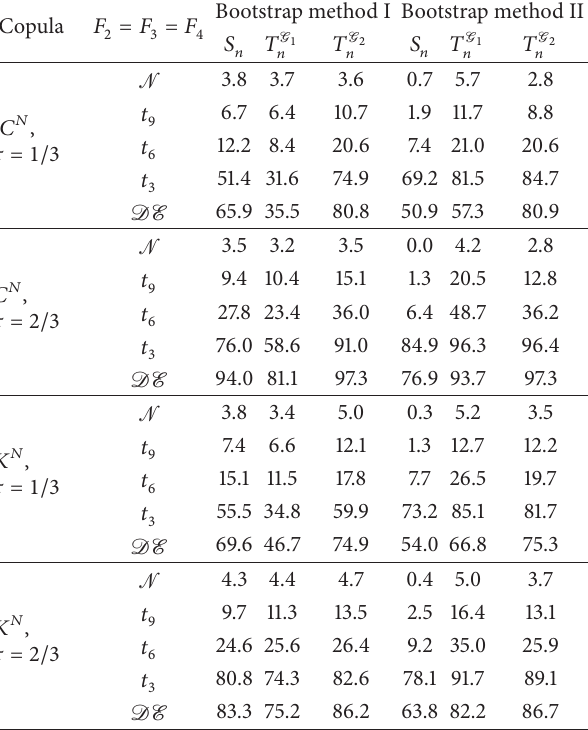
Table 4: Percentages of rejection, as estimated from 1000 replicates, of the null hypothesis of the equality of 𝐾 = 4 distributions up to location/scale under Normal and asymmetric Normal dependence structures when 𝑛 = 200 ; 𝐹 1 is the Normal distribution; 𝐹 2 = 𝐹 3 = 𝐹 4 are either the N , 𝑡 9 , 𝑡 6 , 𝑡 3 , or DE